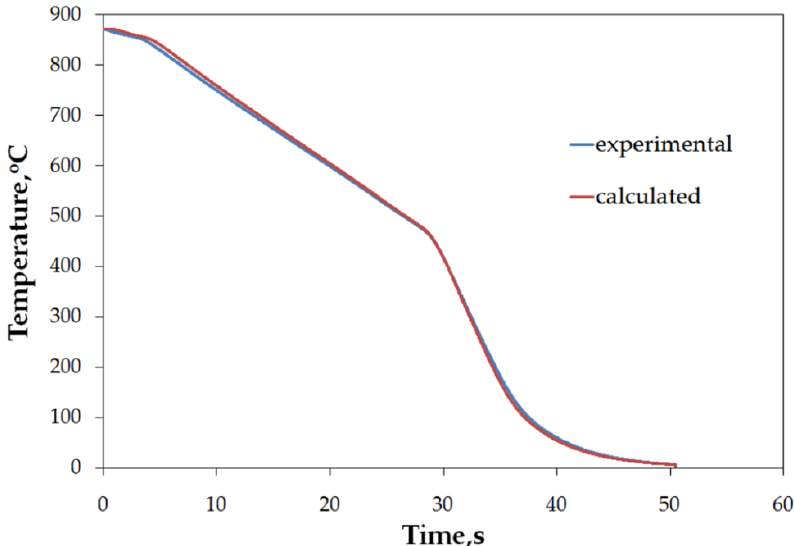
Figure 19. Comparison of experimental and calculated temperature inside of testing probe for quenching according designation setting 1.